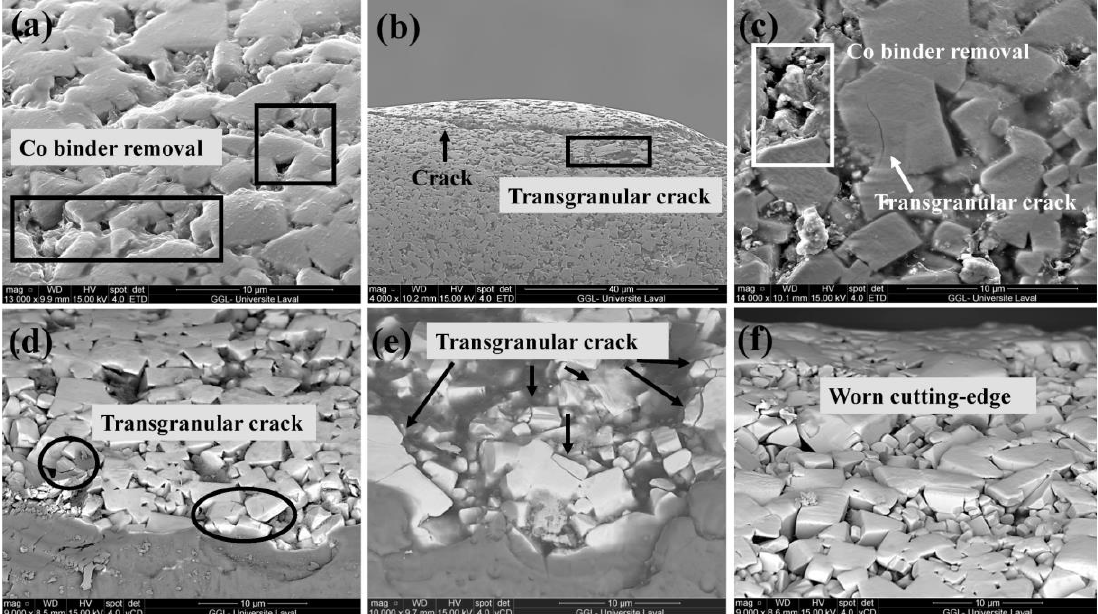
Figure 28. SEM micrographs of the defects on the cutting edges (clearance face view): ( a – c ) saws #2, 4, and 6, respectively after 480 min of sawing and ( d – f ) saws #2, 4, and 6, respectively after 960 min of sawing.